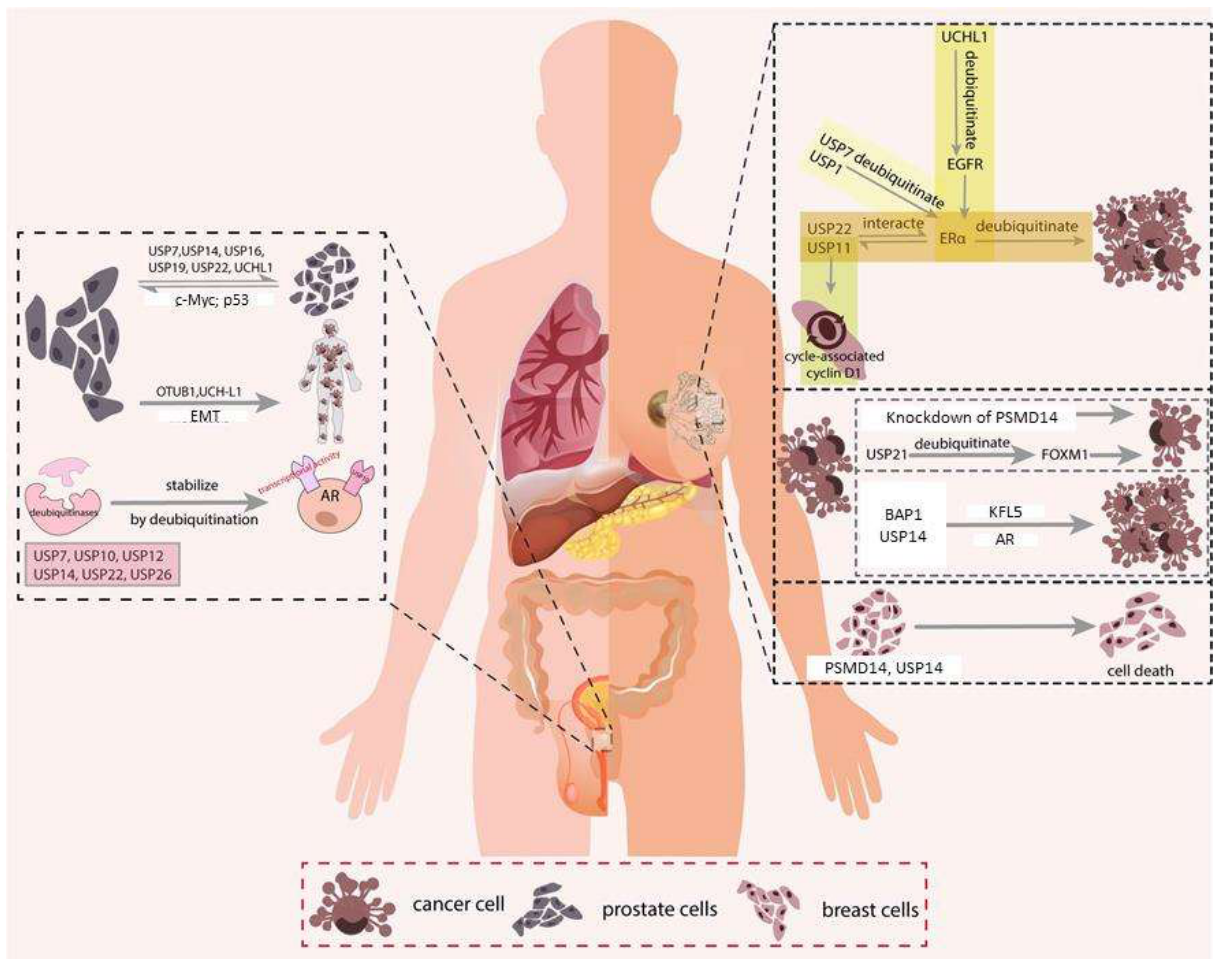
Figure 3. Roles of deubiquitinases (DUBs) in breast and prostatic cancer. The right panel describes the DUBs that related to the breast cancer. Breast cancer is linked to the ER signaling pathway, and the DUBs, such as UCHL1, USP1, USP7, USP11, and USP22 could regulate the ER signaling pathway and thus affect the cell cycle. Besides, DUBs such as BAP1, and USP14 act on KFL5 and AR respectively and play roles in proliferation. DUBs such as USP21 participate in cell death of the cancer cells. The left panel shows the prostatic cancer related DUBs. Prostatic cancer is linked to the AR signaling pathway. DUBs such as USP7, USP10, USP12, USP14, USP22, and USP26 stabilize the AR related proteins and affect various cellular events. In addition, DUBs such as USP7, USP14, USP16, USP19, USP22, and UCHL1 target on c-Myc and p53 that are related to the cell proliferation and cell death. Lastly, and DUBs such as OTUB1, and UCHL1 regulate the EMT and thus affect the metastasis. Detailed mechanisms can be referred to the main text.